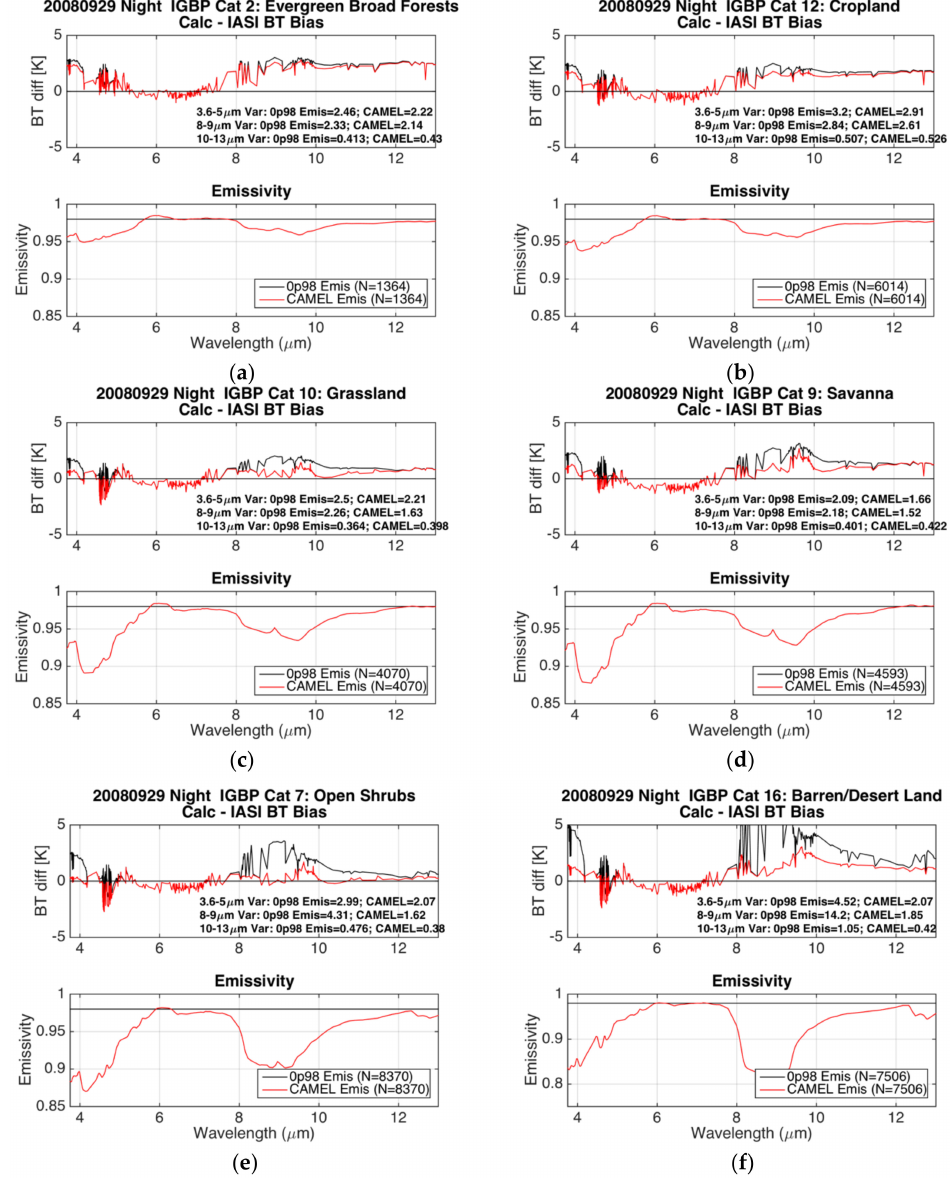
Figure 9. Nighttime RTTOV calculated minus observed IASI BT biases ( top panels ) for a constant 0.98 emissivity (black) and the CAMEL emissivity dataset (red) with associated mean emissivity spectra ( bottom panels ) for 29 September 2008 for the ( a ) evergreen broad-leaf forest; ( b ) cropland; ( c ) grassland; ( d ) savanna; ( e ) open shrub; and ( f ) barren/desert land IGBP categories. De-biased variances (explanation in text) are used as the better emissivity estimate and are shown in figures. The number of samples, N, are listed in figure legends. Note that the bottom panel y -axis limits change for the desert/barren land